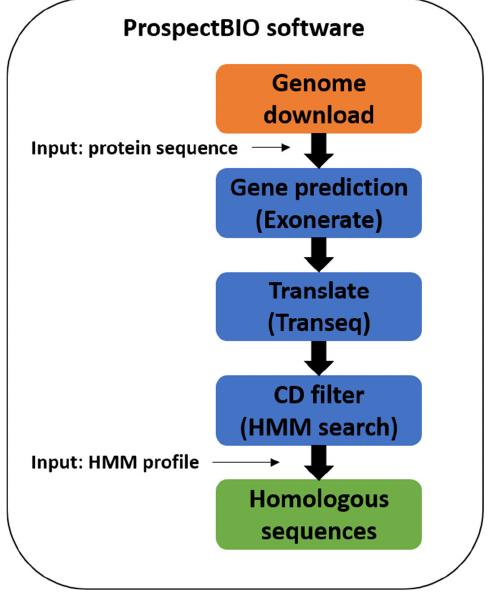
Figure 1. Prospecting methodology to obtain potential protein sequences using the ProspectBIO